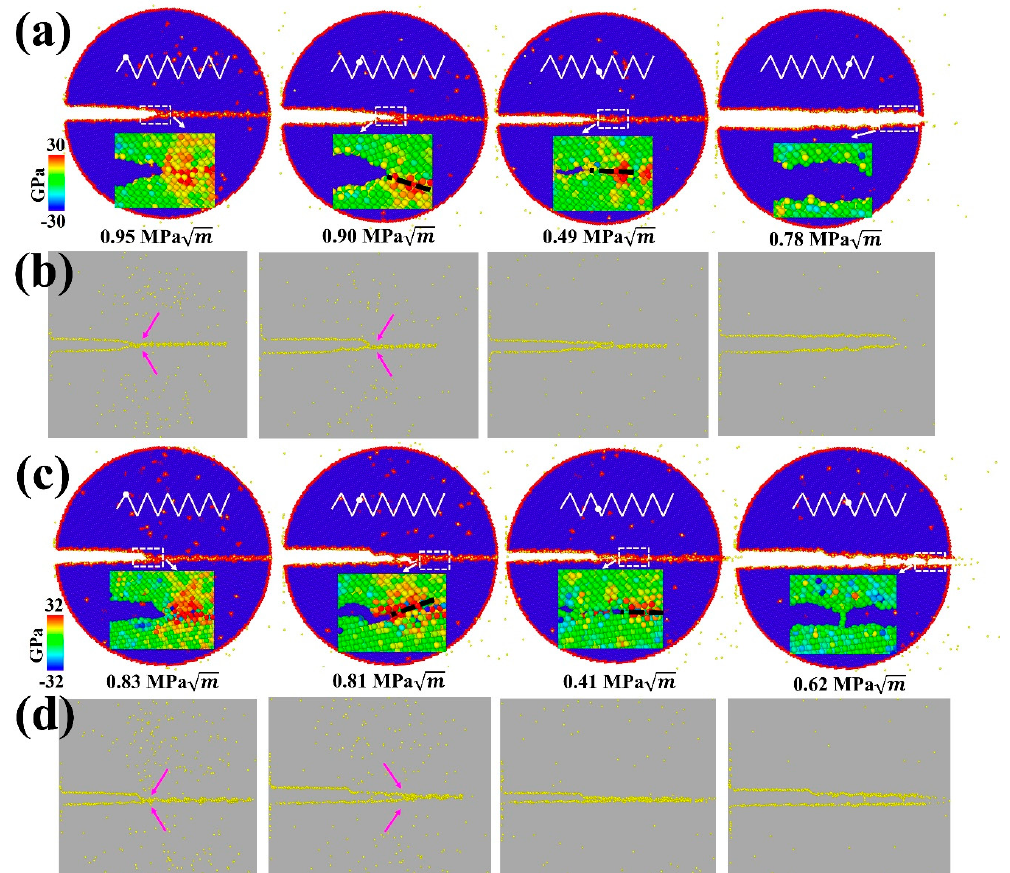
Figure 8. MD snapshots illustrating the crack propagation along the predicted ductile direction of ( a ) Σ 17 (2 2 3) GB and ( c ) Σ 11 (5 5 7) A ( 7(cid:3364) 7(cid:3364) 1) B GB with 135 mppm H atoms under cyclic loading. The upper inserts are loading spectra, and lower inserts of each image represent the stress field distribution and are colored by the hydrostatic stress value. ( b , d ) The cor- responding H distribution maps under different stress intensities. The possible cracking path is marked by a dark dash, and H diffusion is indicated with pink arrows.